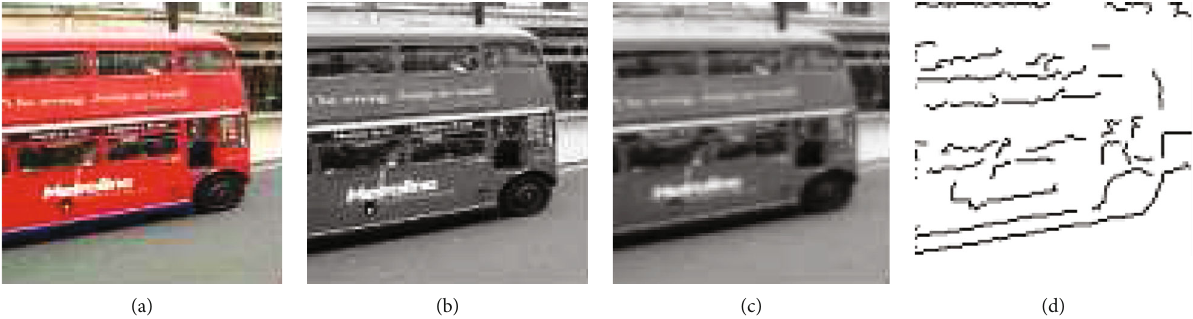
Figure 2: From raw image to edge detection: (a) Raw image, (b) image after grey-scale conversion, (c) blurring after median fi ltering, and (d) edges extracted from the